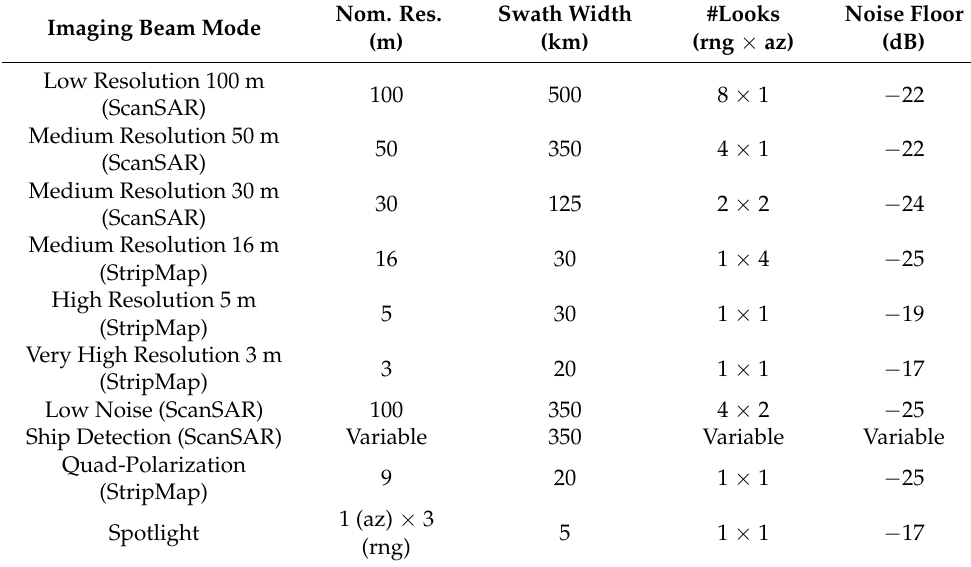
Table 1. Summary of the characteristics of the RCM imaging beam